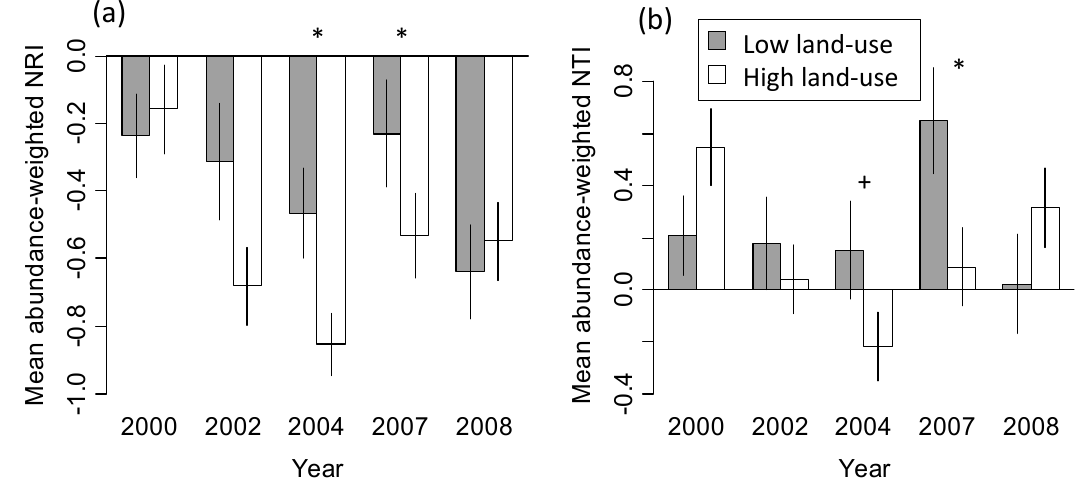
Figure 2. Mean phylogenetic relatedness of seedlings within 2-m 2 plots that experienced varying effects of past land use. Panels ( a , b ) show mean abundance-weighted values of Net Relatedness Index (NRI) and Nearest Taxon Index (NTI), respectively, for the full data set. Gray bars indicate results for seedling plots located in low-intensity land use portion of Luquillo Forest Dynamics Plot (LFDP) and white bars indicate results for seedling plots located in high-intensity land-use portion of LFDP. Stars (*) and pluses (+) indicate years where values differed between land use history categories at the α = 0.05 and α = 0.10 levels, respectively.